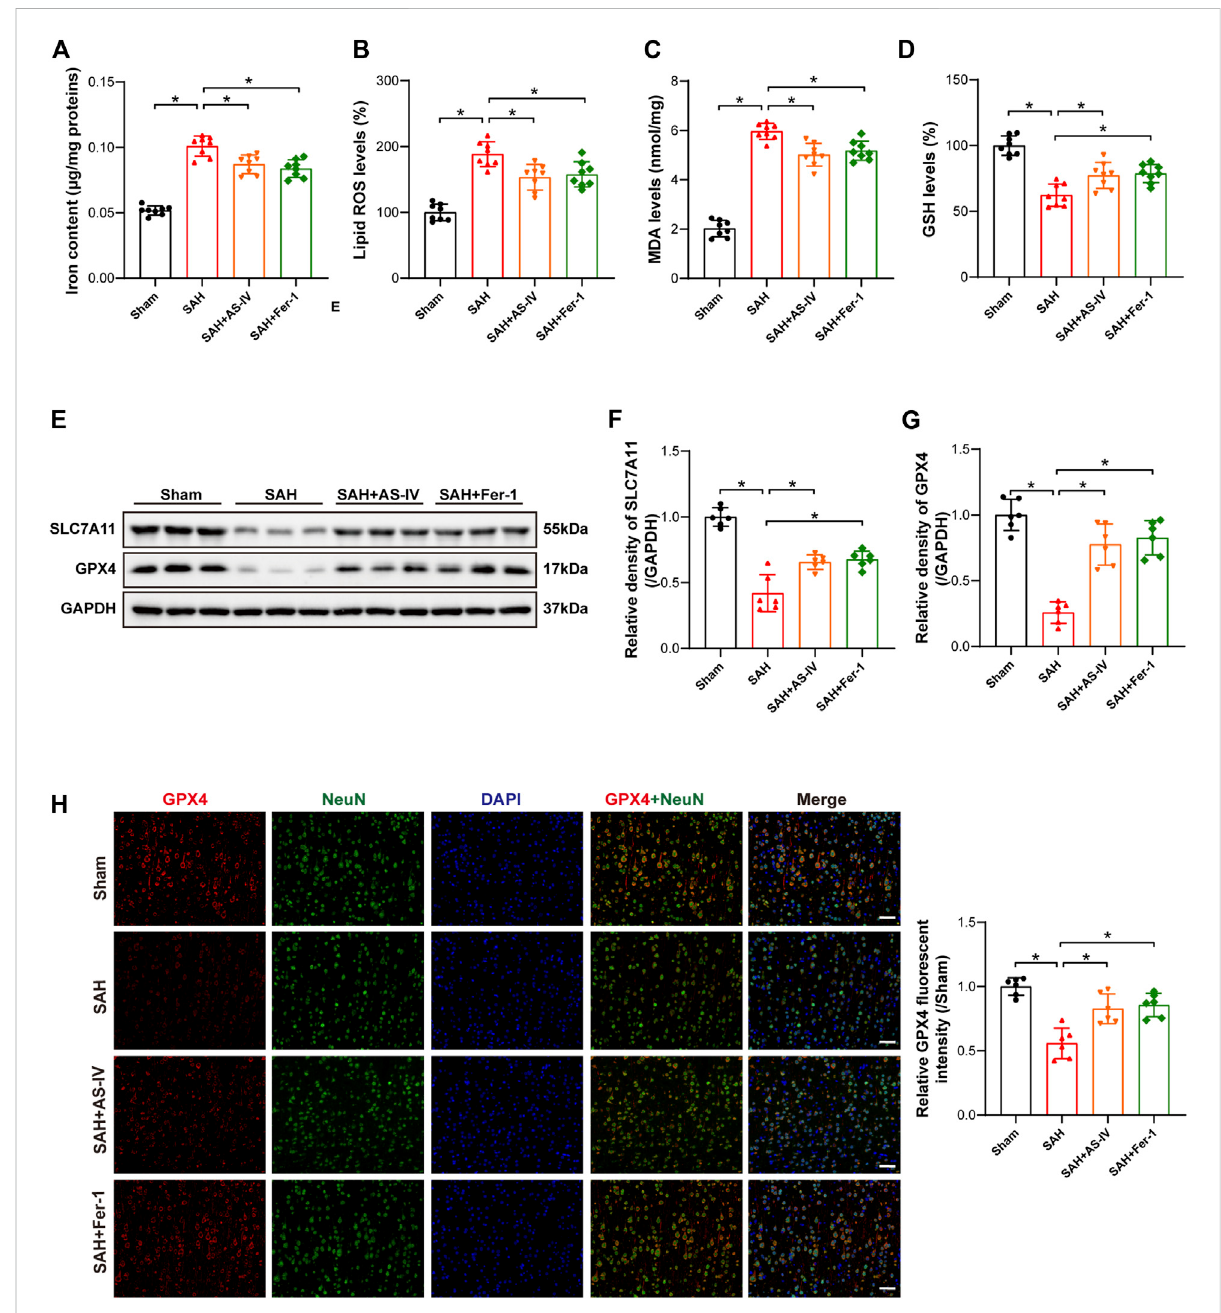
FIGURE 3 AS-IV and Fer-1 treatment attenuated ferroptosis 24 h after SAH. (A) Quantitative analysis of iron concentrations after SAH (n = 8). (B – D) Quantitative analysis of lipid ROS, MDA, and GSH levels (n = 8). (E – G) Westernblotanalysis of protein expression levels of SLC7A11 and GPX4 (n = 6). (H) Typical double immuno fl uorescence images of GPX4 and NeuN (scale bar = 50 μ m). Data are represented as mean ± SD. * p < 0.05, NS: not statistically signi fi